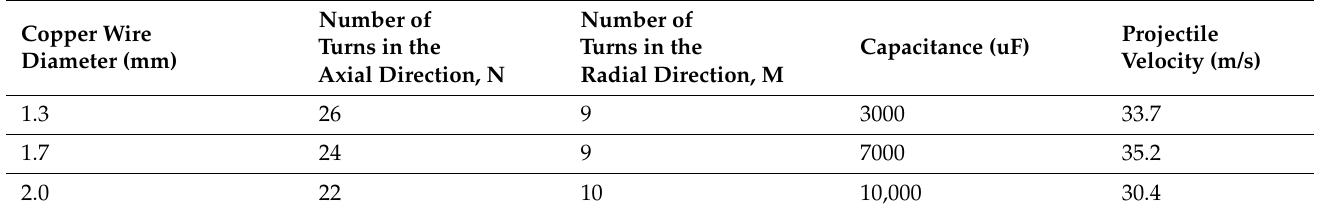
Table 2. Results of the finite element analysis giving optimal coil gun shapes according to the copper wire diameters.